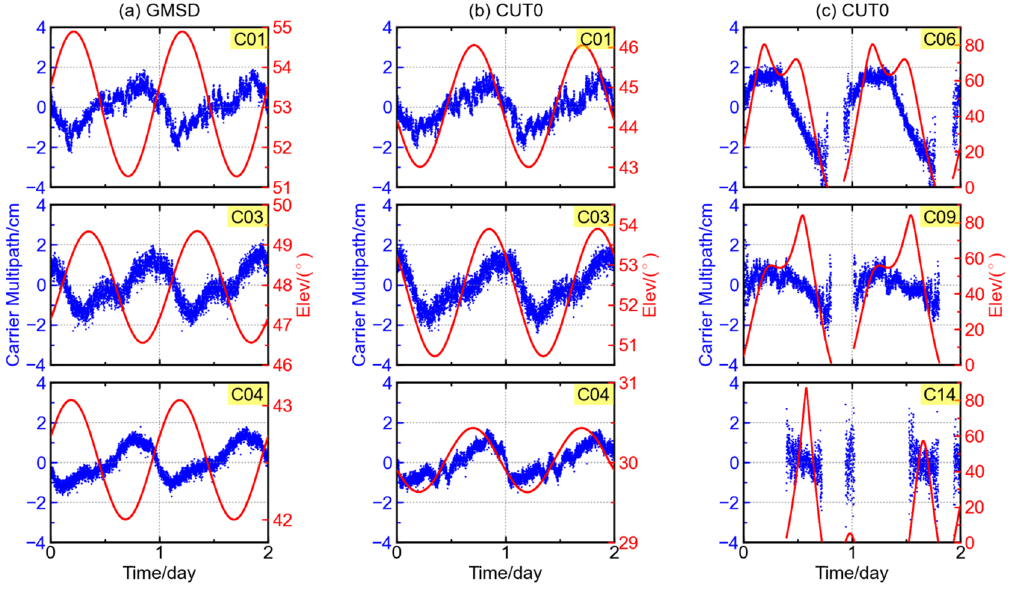
Figure 10. GFIF combination (blue) and elevation (red) of BDS satellites at stations ( a ) GMSD and ( b,c ) CUT0.